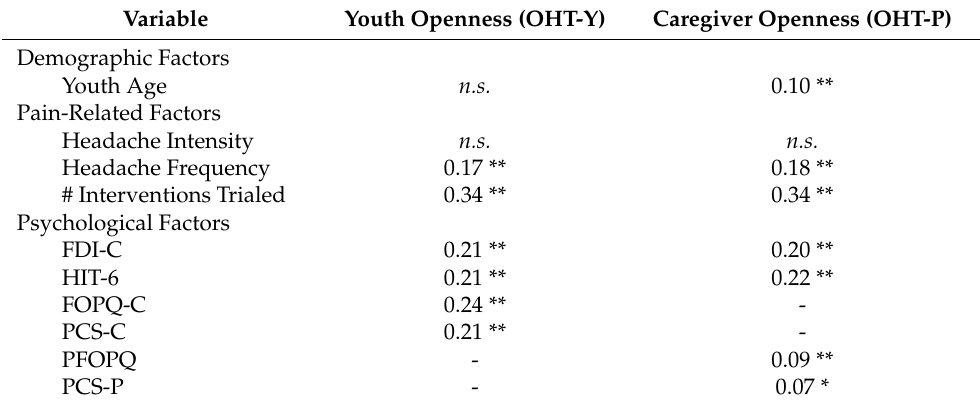
Table 5. Correlation Matrix of between Youth/Caregiver Openness and Pain-Related/Psychological Factors. Variable Youth Openness (OHT-Y) Caregiver Openness (OHT-P) Demographic Factors Youth Age n.s. 0.10 ** Pain-Related